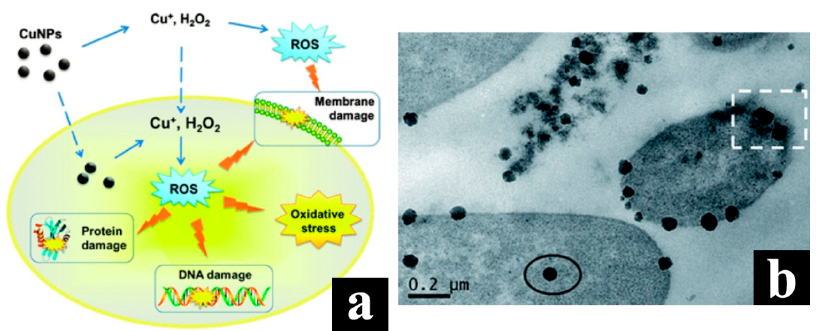
Figure 6. ( a ) Schematic diagram of the main toxicity mechanism of Cu nanoparticles; ( b ) Transmission electron microscope results of Escherichia coli cells after exposure to 80 mg·L − 1 Cu nanoparticles for 30 min (Reproduced with permission [156]).